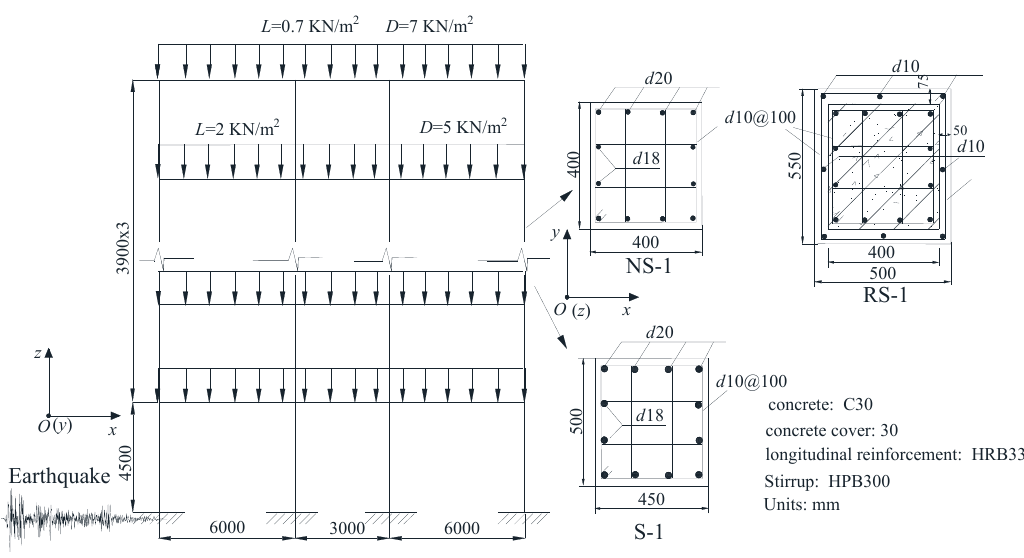
Figure 6. Design parameters of S-1, NS-1, and RS-1.